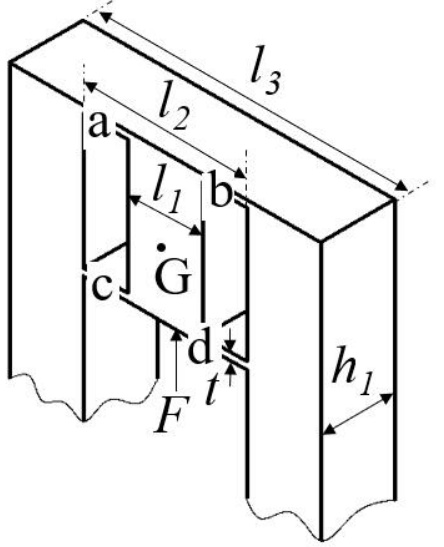
Figure 4. The guidance mechanism in the base